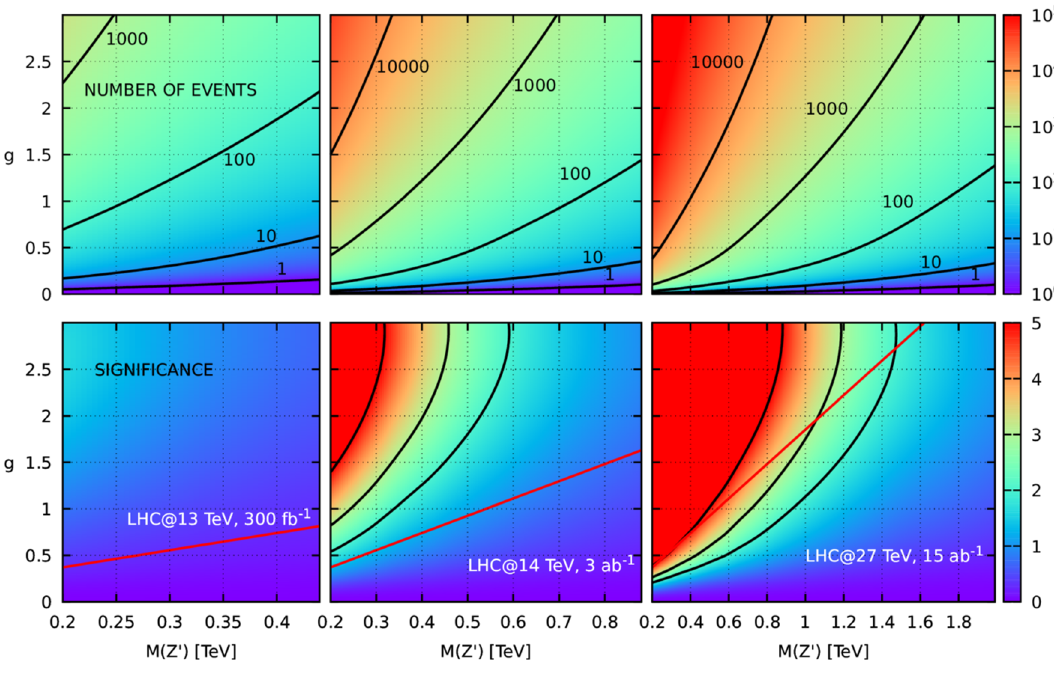
Figure 9. Number of events (upper plots) and signi(cid:12)cance (lower plots) for the production of a Z 0 coupled only to muons and taus, and decaying into muons, in the mass-coupling plane ( M Z 0 ; g ) in proton-proton collisions at 13 TeV with 300 fb (cid:0) 1 (left), 14 TeV with 3 ab (cid:0) 1 (center) and 27 TeV with 15 ab (cid:0) 1 (right) of integrated luminosity. The contours corresponding to 1, 10, 10 2 , 10 3 and 10 4 events are shown in black in the upper plots, and the 2-, 3- and 5-sigma contours are shown in the lower plots. The region above the red line, corresponding to M Z 0 = g (cid:2) 540 GeV, is excluded by neutrino trident